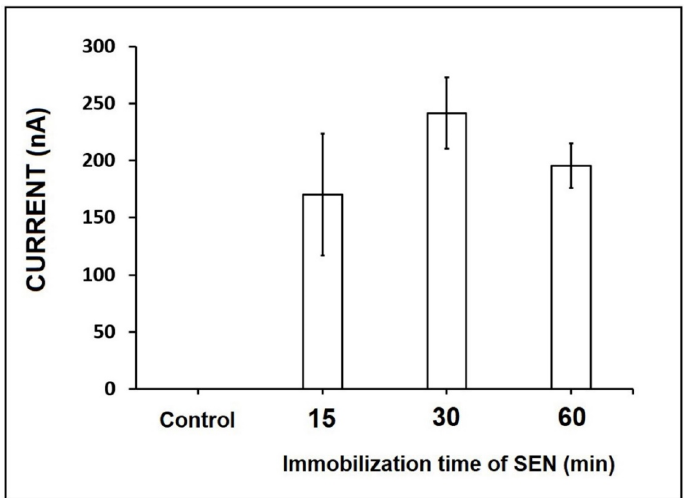
Figure 1. Voltammograms of (a) control experiment performed by PGE in PBS in the absence of SEN; (b) oxidation signal of 50 µg/mL SEN. Inset figure presenting the chemical structure of SEN. The effect of immobilization time on the immobilization efficiency of SEN onto the PGE surface was examined based on changes in the response. An amount of 50 µg/mL SEN (its stock solution was prepared in DMSO) was immobilized onto the electrode sur- face during 15, 30, and 60 min, and the oxidation signal of SEN was measured respectively as 200.50 ± 74.39 nA (RSD%, 37%, n = 3), 241.67 ± 31.07 nA (RSD%, 12%, n = 3), and 197.80 ± 40.08 nA (RSD%, 20%, n = 3) (Figures 2 and S2). Since the highest and reproducible oxi- dation signal of SEN was measured in 30 min immobilization time (Figure 2), it was cho- sen as the optimum immobilization time.